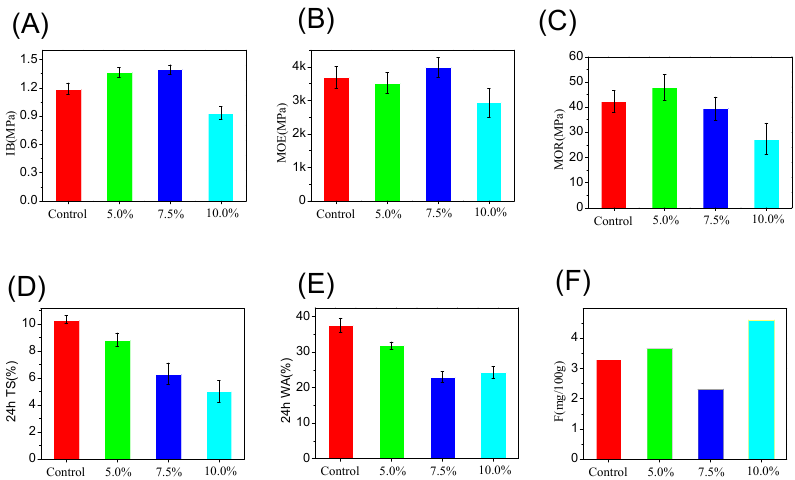
Figure 7. Mechanical properties of medium density fiberboard. ( A ) Internal bond strength (IB), ( B ) modulus of elasticity (MOE), ( C ) modulus of rupture (MOR), ( D ) 24-h thickness swelling rate, ( E ) water adsorption of fiberboard, ( F ) formaldehyde emission of medium density fiberboard.